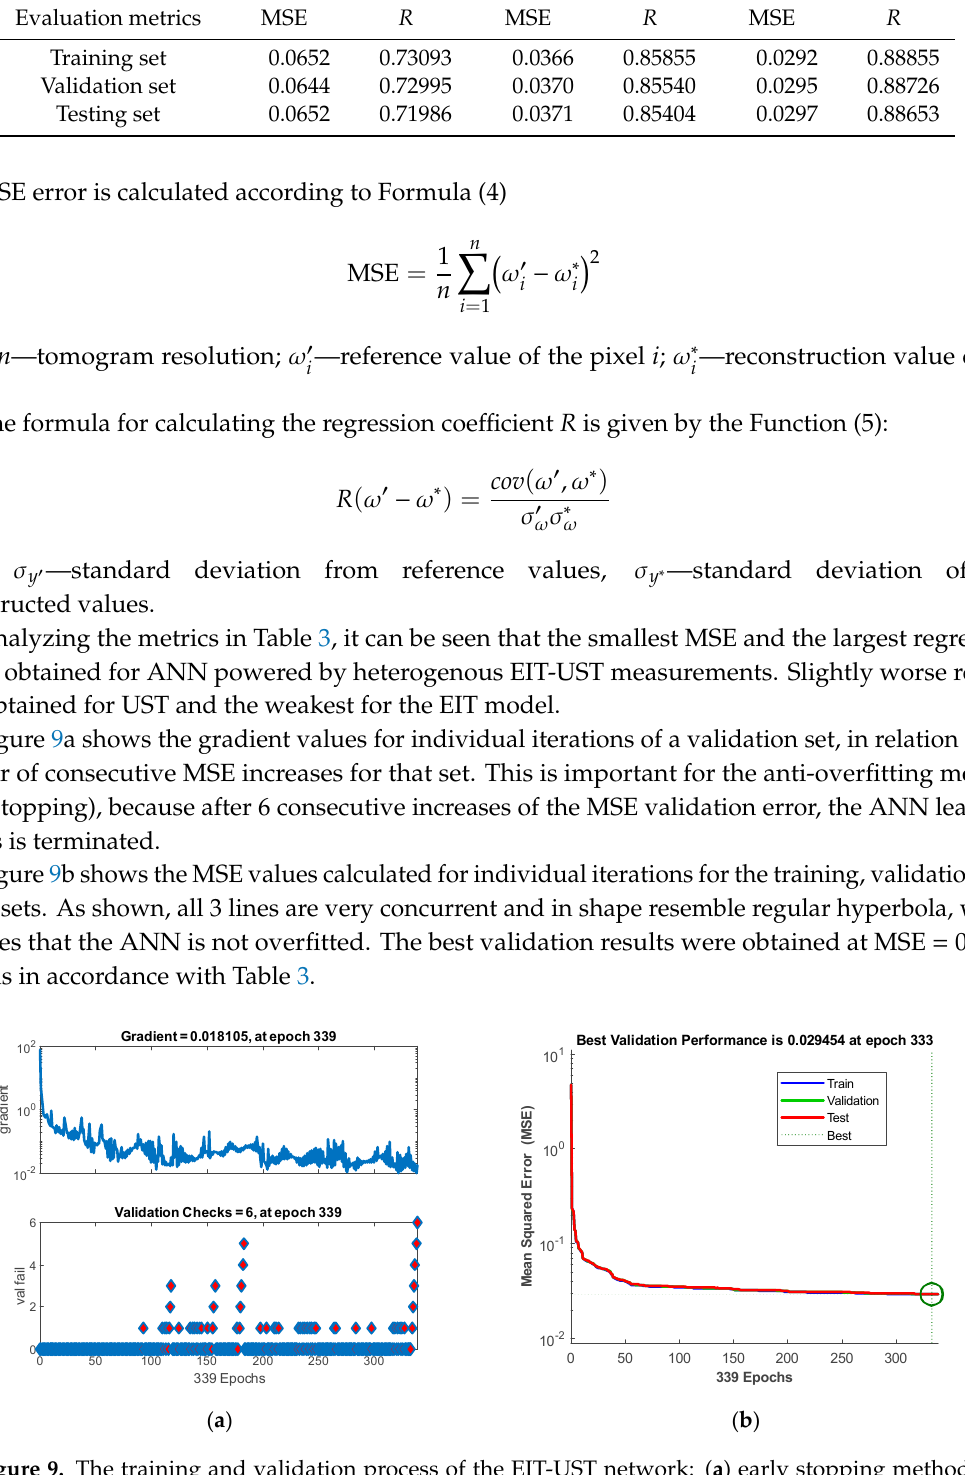
( b ) ( c ) Figure 10. Regression statistics for ( a ) training set, ( b ) validation set and ( c ) testing set.